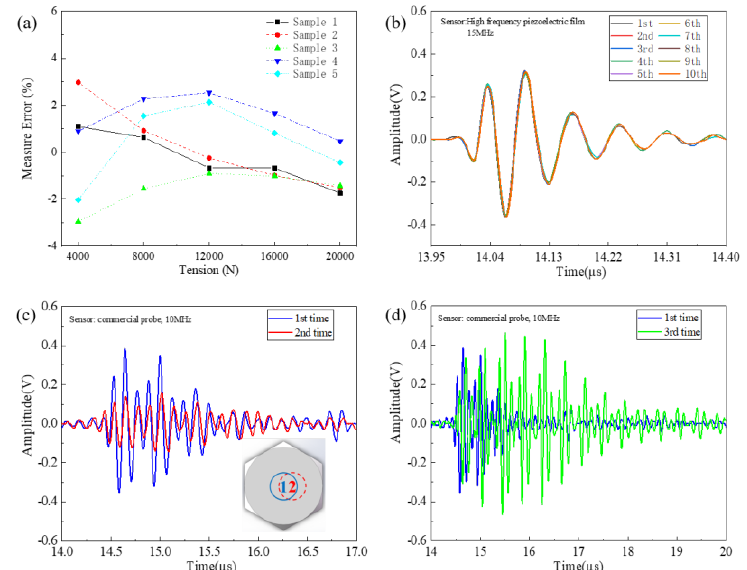
Figure 8. ( a ) The relative error of ultrasonic measurement based on the high-frequency sensor; ( b ) temporal ultrasonic wave signs for ten different contact positions between the magnet connector and smart bolt; ( c ) temporal ultrasonic wave signs for two different contact positions between the commercial piezoelectric probe and smart bolt (inset shows schematic diagram of two different detection positions on the surface of the bolt head.); ( d ) temporal ultrasonic wave signs for two different couplant layer thicknesses.